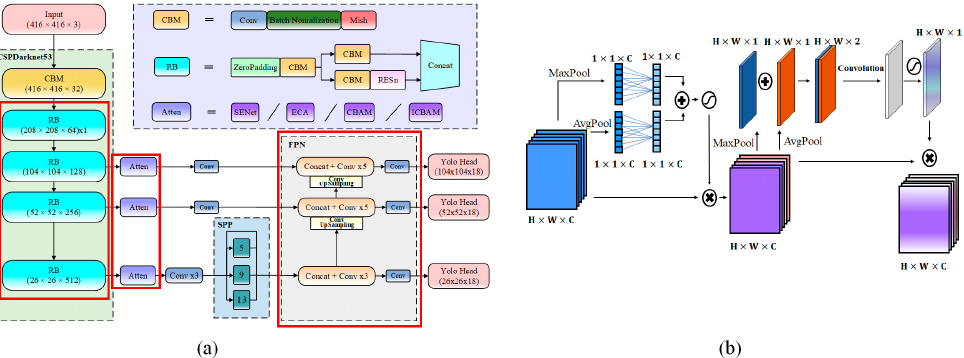
Figure 3. Improved method of YOLOv4. CBM, Conv + Batch Nomalization + Mish; RB, Resblock_body; RESn, Residual Networks; SENet, cross-stage partial network; ECA, efficient channel attention; CBAM, convolutional block attention module; ICBAM, self-improved attention mechanism; SPP, spatial pyramid pooling; H, Hight; W, width. ( a ) Improved YOLOv4 model. The red boxes are the contribution of the improved method as compared to the benchmark method in the methodology diagram; ( b ) Improved hybrid attention mechanism (ICBAM).